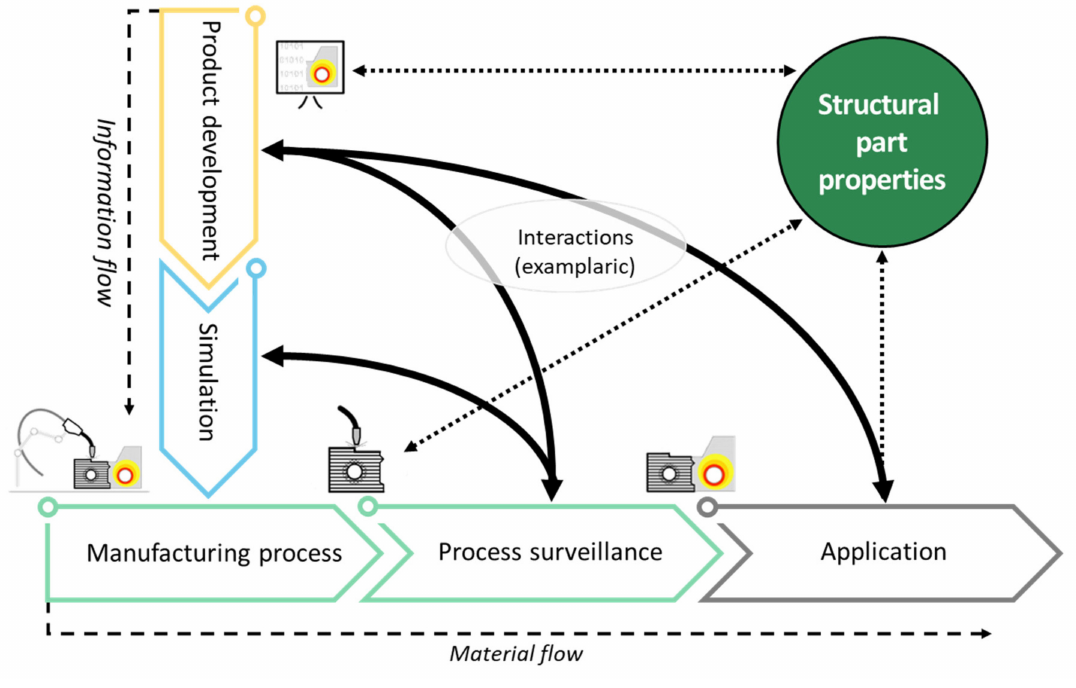
Figure 7. Process chain for WAAM [1].